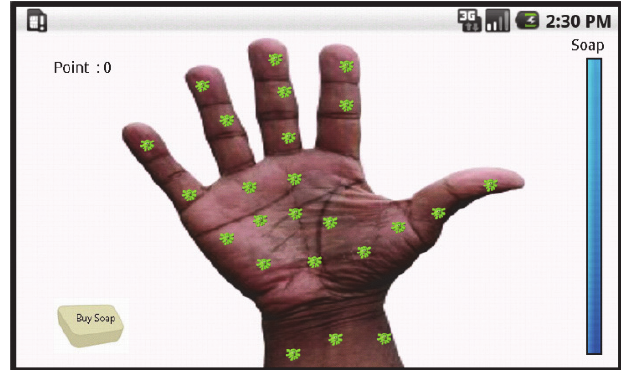
Figure 5 . An interactive part of the game In the designs by the children, game rewards were also identified as an important element. In the implemented game the reward system that was developed focused on the children gaining animals for their zoo. This idea appeared in several of the children’s designs and was considered neutral enough for use with children from another country the zoo screen is shown in Figure 6.